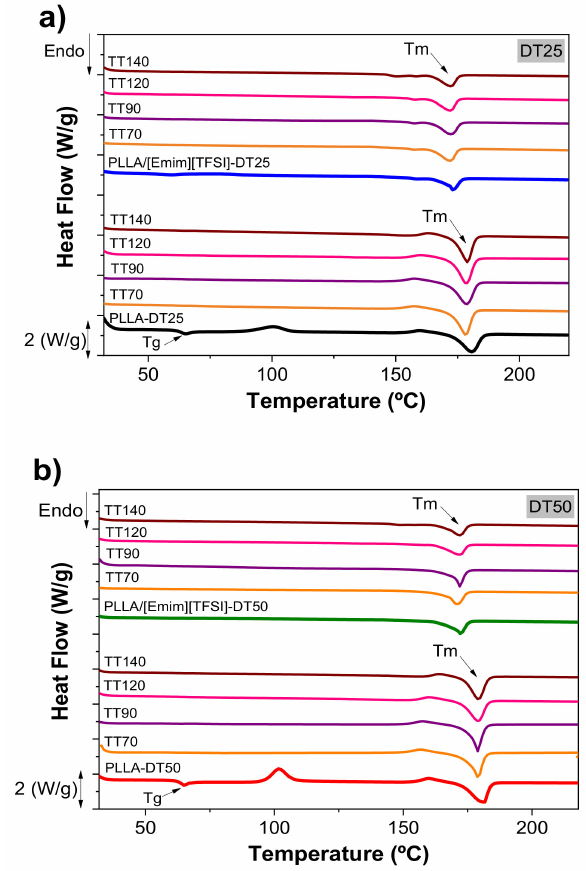
Figure 4. DSC curves as a function of the post-thermal treatment temperature for the PLLA-based films dried at: ( a ) 25 ◦ C and ( b ) 50 ◦